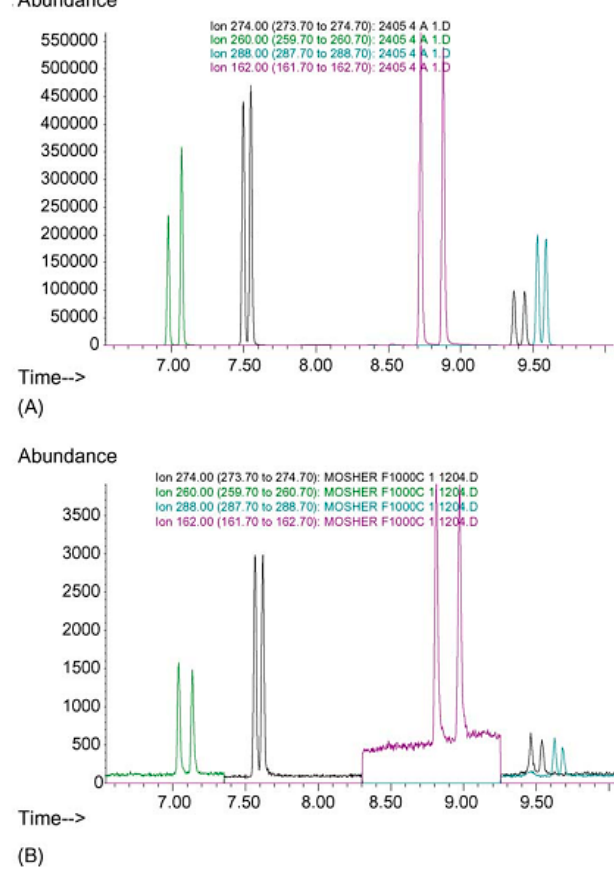
Figure 3. Chromatogram representing the enantioseparation of R / S -AM, R / S -MA, R / S -MDA, R / S -MDMA and R / S -MDEA as R -MTPCl derivatives in whole blood concentrations at ( A ) 2 µ g/g and ( B ) at 0.002 µ g/g, respectively. Reproduction with permission of Elsevier (Figure 1 from Rasmussen et al. [67]).